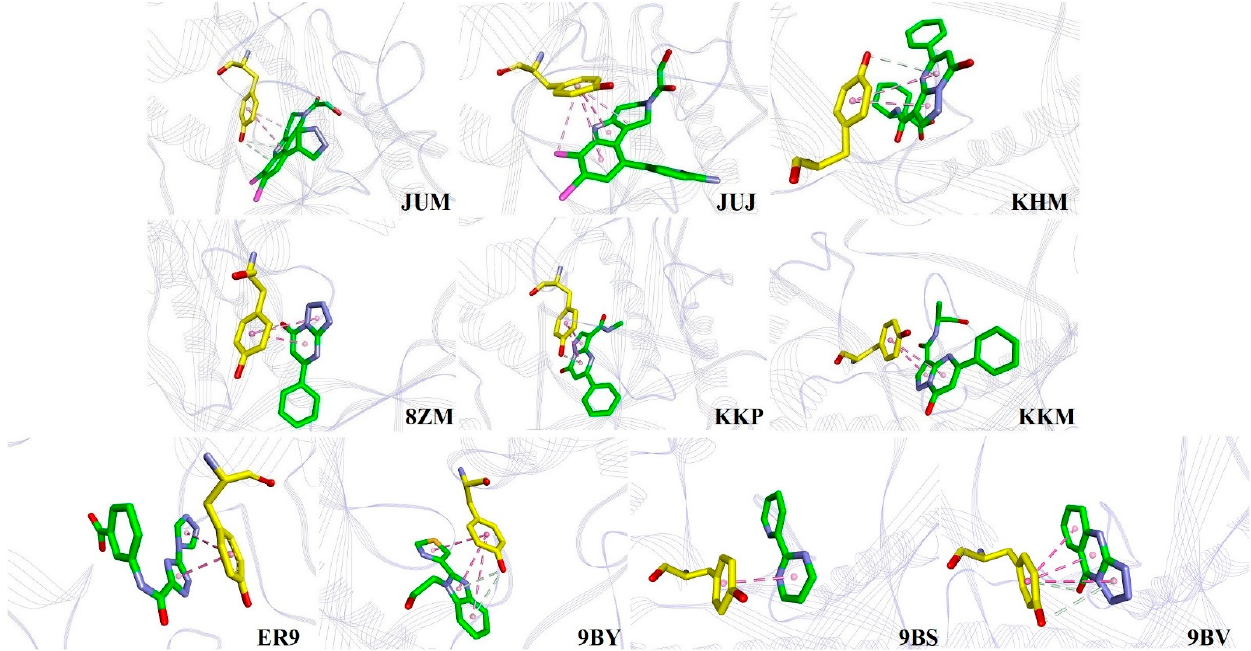
Figure 6. Binding of the 10 inhibitors used in this study with Y436. The C atoms of inhibitors and Y436 are shown in green and yellow, respectively. The pink and white dashes represent the π · · · π stacking and O ‒ H· · · π interactions, respectively. The light pink dashes in JUM and JUJ show the C ‒ H· · · π interactions. The schemes of the atom and protein colors are the same as in Figure 5.